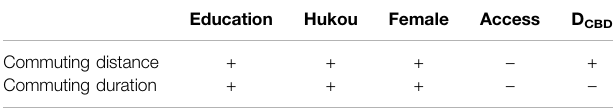
TABLE 4 | The impact factors between commuting distance and commuting